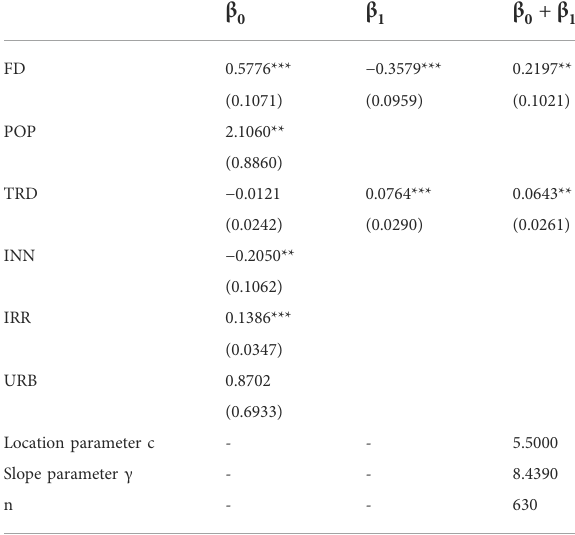
FIGURE 2 Smooth transition